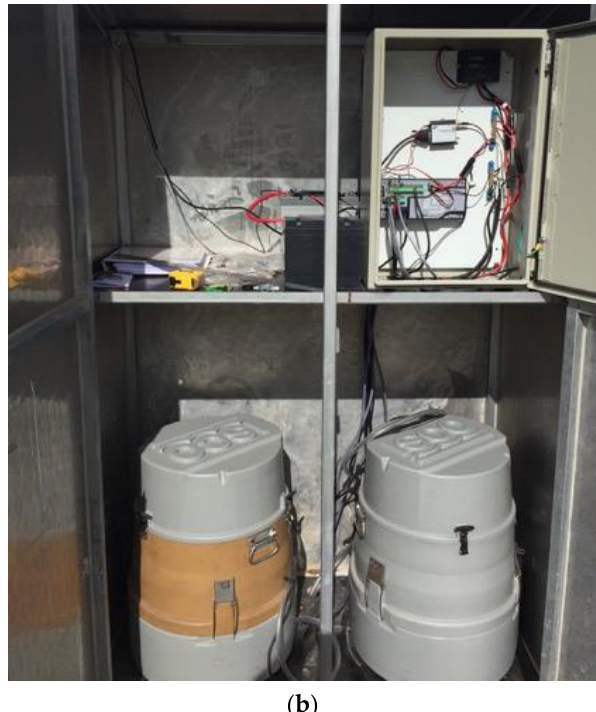
Figure 3. Installed instrumentation: ( a ) Instrumentation layout [8]; ( b ) Influent and effluent autosamplers and data loggers.